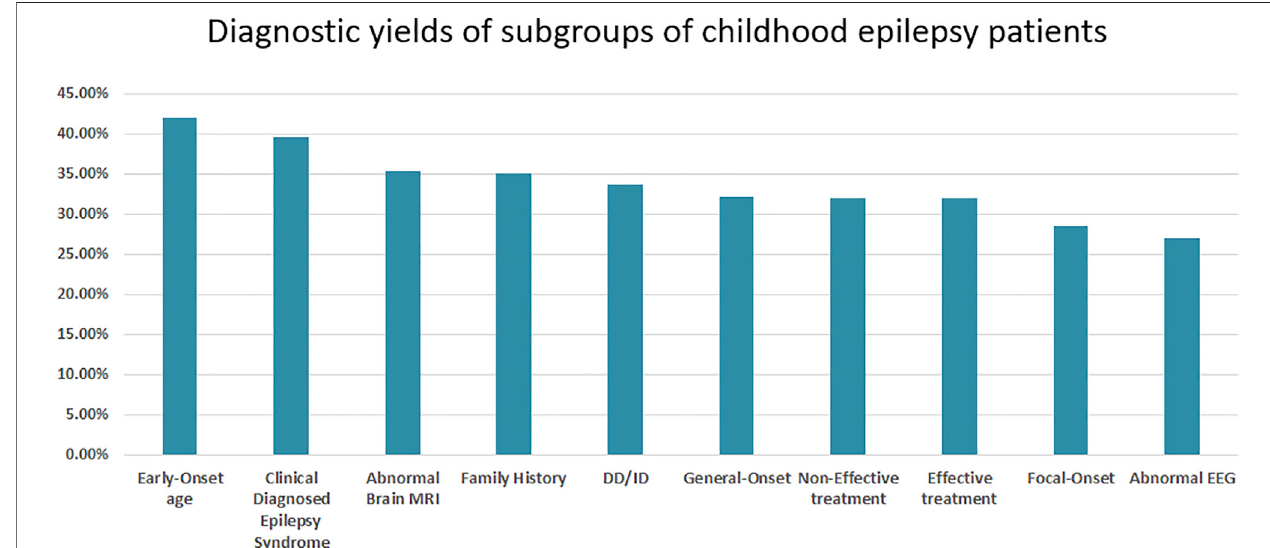
FIGURE 2 | The diagnostic yield of the subgroups of childhood epilepsy patients.